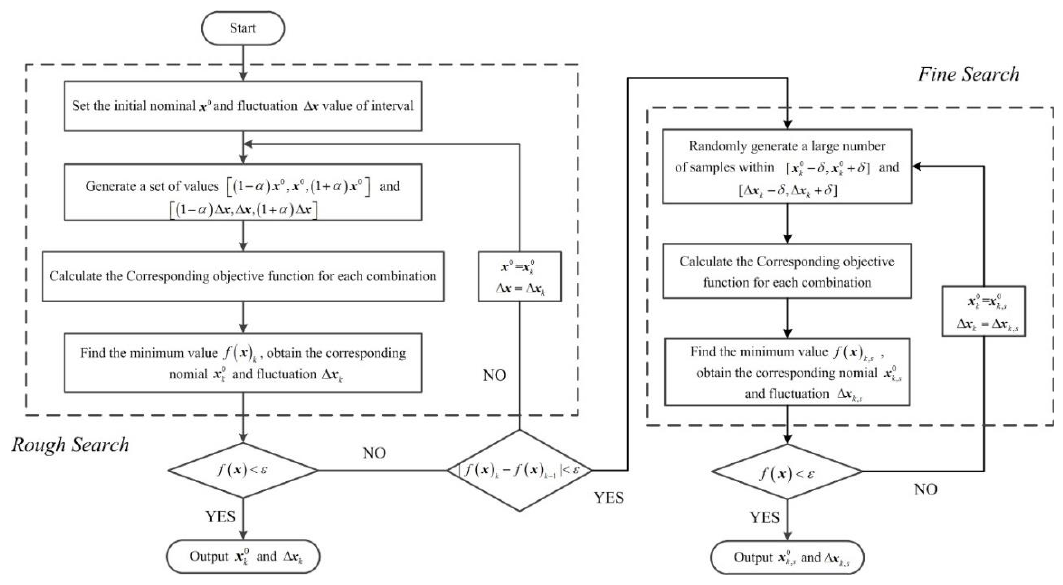
Figure 7. Flowchart of the parameter interval updating strategy.